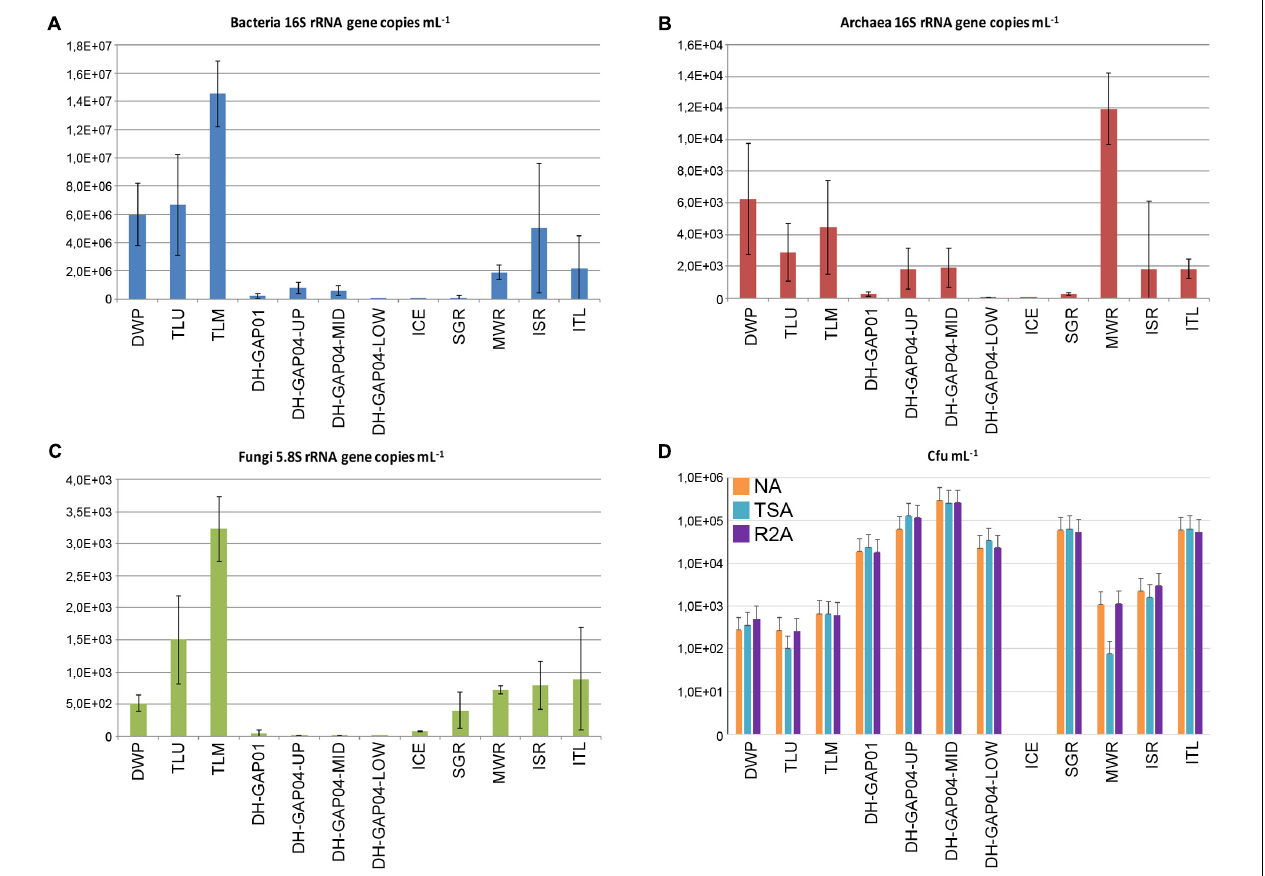
FIGURE 2 | The mean abundance of (A) bacteria, (B) archaea, (C) fungi estimated by quantifying the bacterial and archaeal 16S rRNA gene copies and the fungal 5.8S rRNA gene copies mL − 1 sample water. (D) The mean number of colony forming units (cfu) mL − 1 in the different water samples grown on Nutrient Agar (NA), Tryptic Soy AgR (TSA) and R2A agar. The error bars show standard deviation. In (A–C) the number of biological replicants was 3, of which 3 individual qPCR reactions were performed for each replicant. In (D) the mean number of cfu is based on dilution series including 4–6 plates per